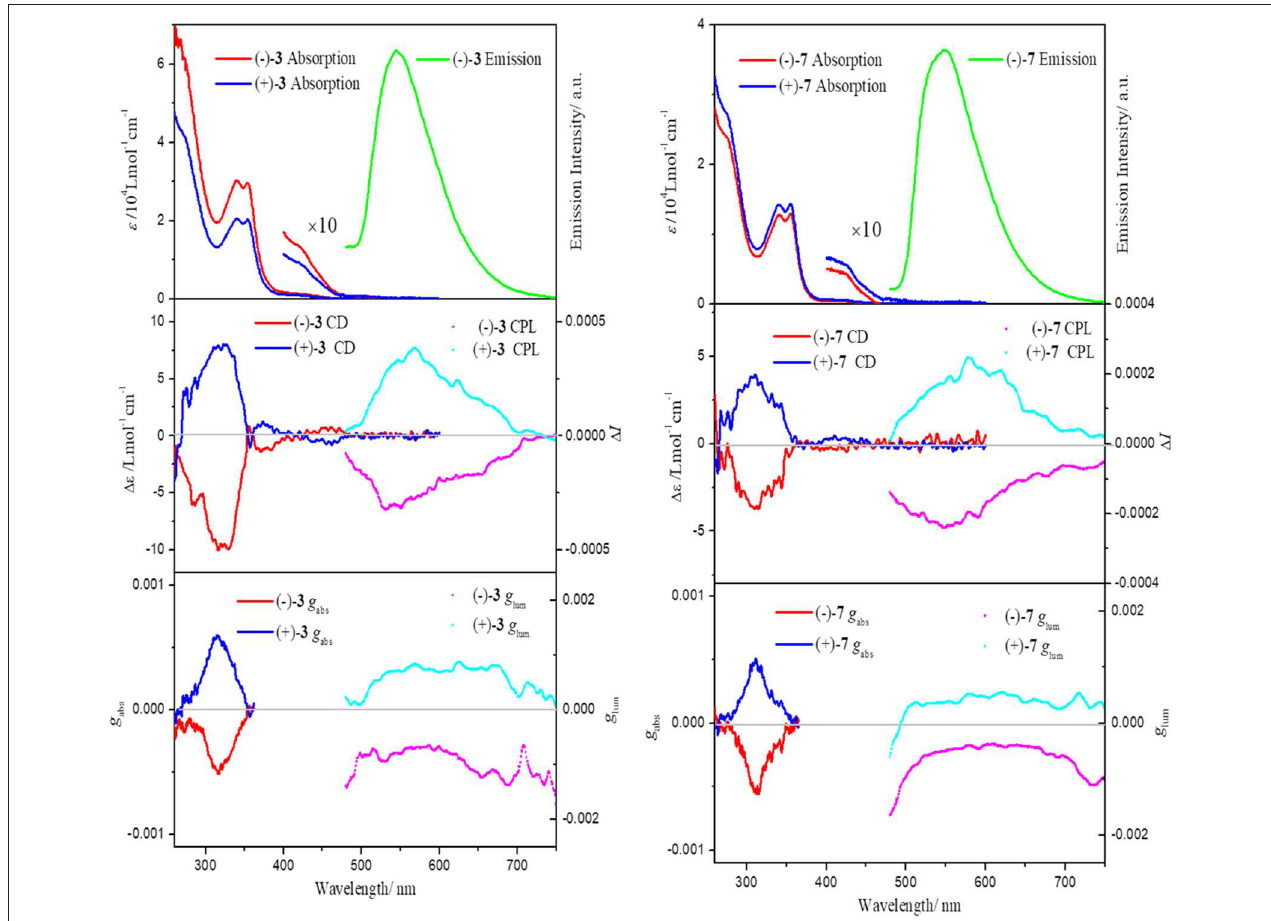
FIGURE 2 | Absorption and emission spectra of (–)- 3 and (–)- 7 in CH 2 Cl 2 (5 × 10 − 5 mol L − 1 ) at T = 298K, λ ex = 420nm ( top ). CD spectra in CH 2 Cl 2 (5 × 10 − 5 mol L − 1 ) at T = 298K ( middle ) and CPL spectra in CH 2 Cl 2 (10 − 3 mol L − 1 ) at T = 298K ( middle ). g abs and g lum factors are shown at the bottom .